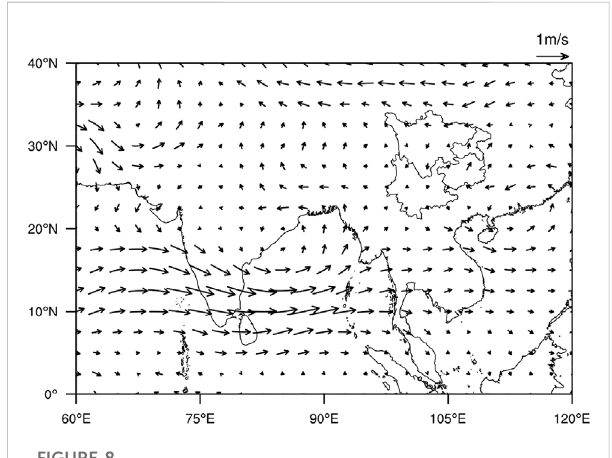
FIGURE 8 Effects of AHR on the horizontal wind (U, V) at 500 hPa in the boreal summer (JJA) from 1992 to 2013 (unit: m s − 1 ).